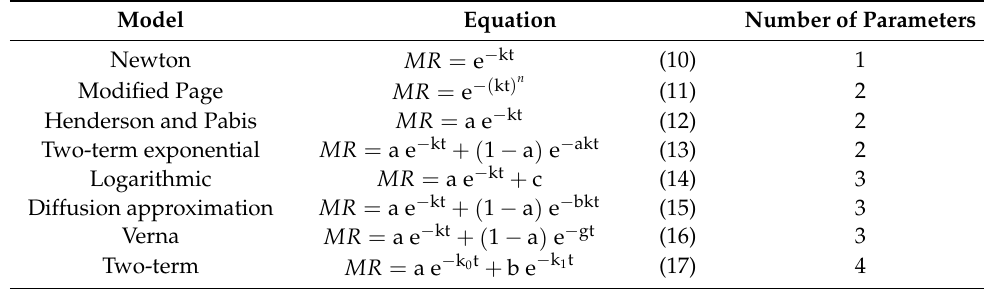
Table 5. Kinetic models used to describe the drying curves of purple basil